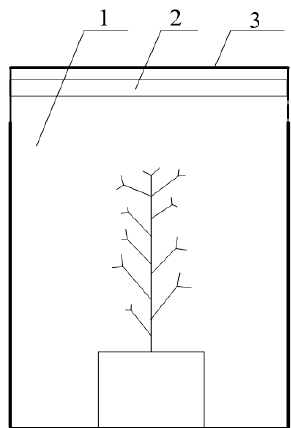
Figure 1. Technical parts of the frost chamber. 1. Basic refrigeration unit; 2. Isolation unit; and, 3. Cold radiation source.